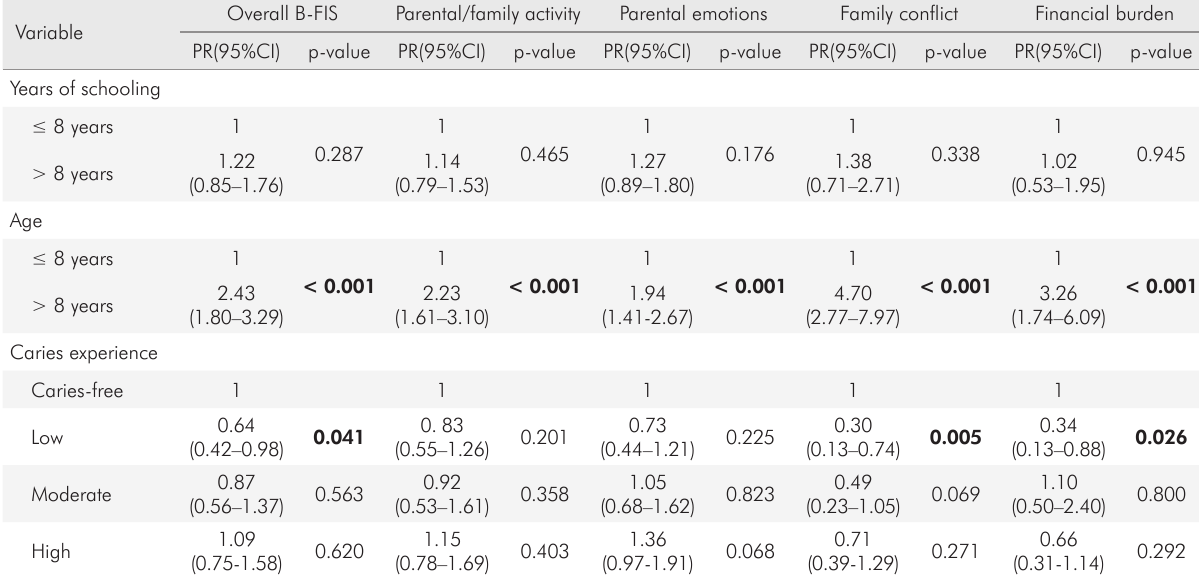
Table 4. Multivariate Poisson regression model for association between independent variables (p < 0.05) and the overall B-FIS and specific